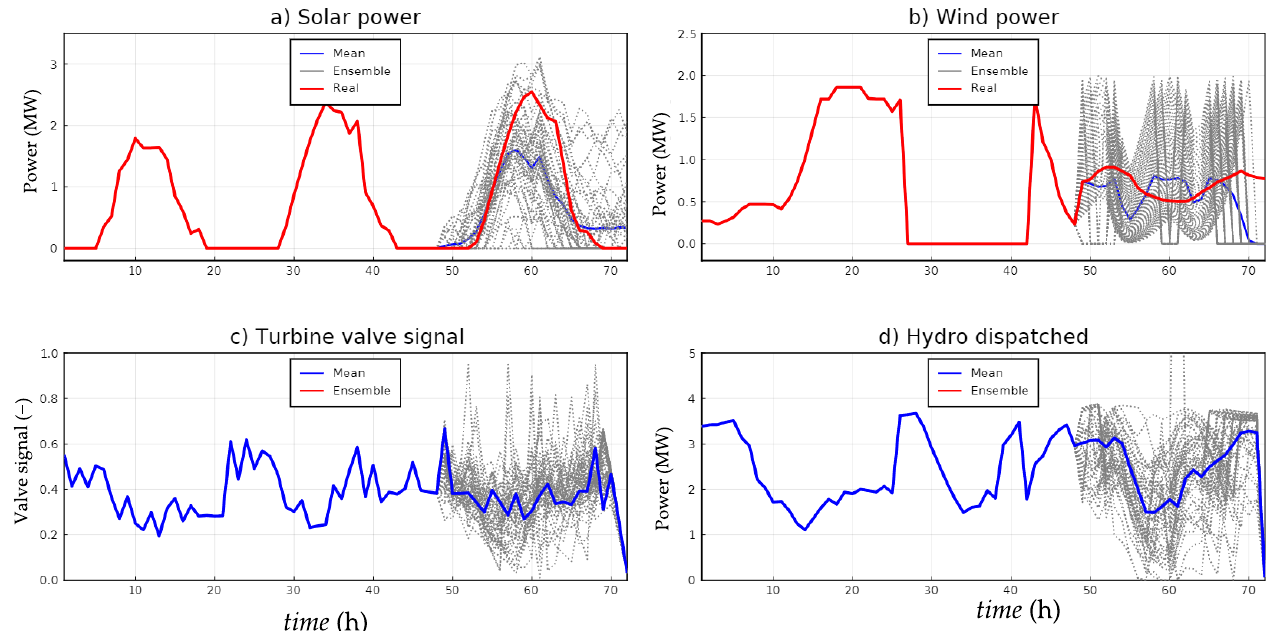
Figure 18. Analysis of deterministic MPC with stochastic disturbances. For each of the scenarios, optimal control input solutions for u v is found. The optimal control input of every scenarios is then plotted